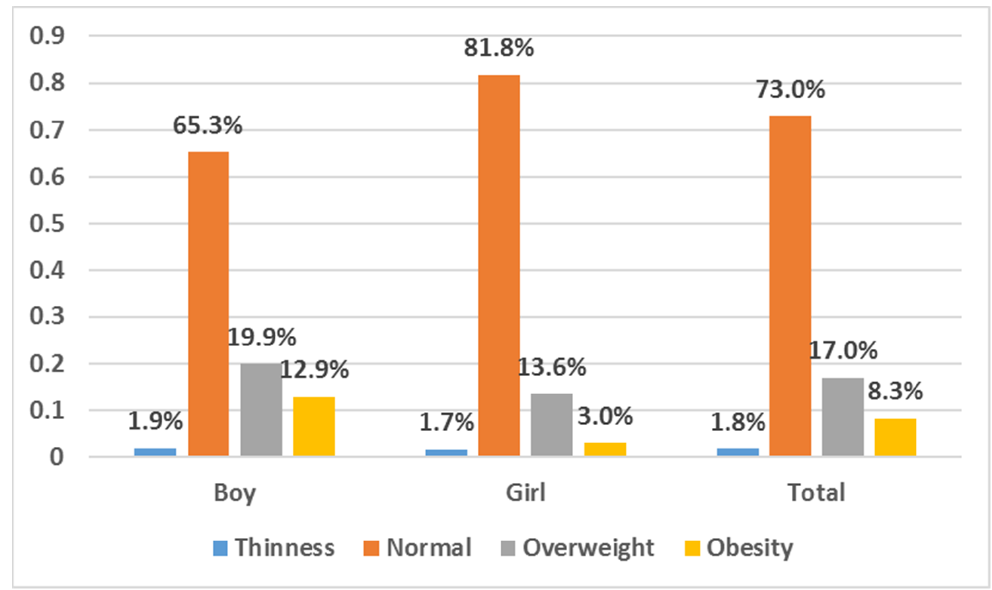
Figure 1. Body mass index ( BMI) categories by stratified by sex (Chi-square test, p < 0.001). Table 1. Sociodemographic information of male school-age children by weight status.